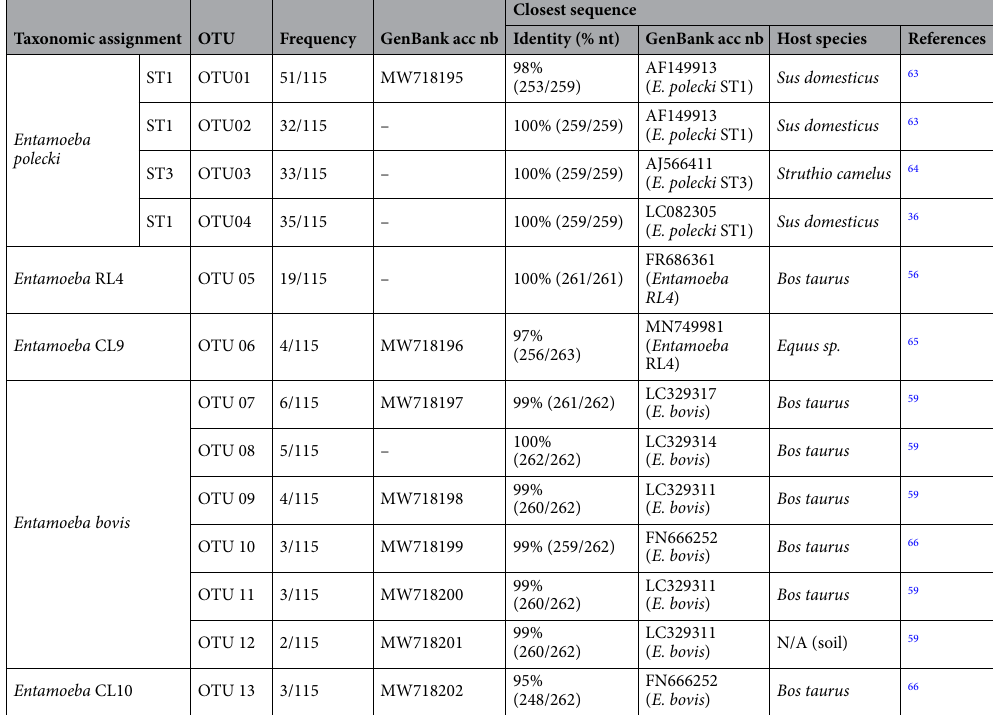
Table 2. Taxonomic assignment of OTUs (~ 260pb) detected in 65 of 115 faecal samples. Frequency of each OTU is given all hosts combined. For each OTU, information on the closest sequence (through BLASTn searches) listed in reference sequences comprise: identity of the sequence, GenBank accession number, host species from which the sequence was amplified for the first time, and bibliographic reference associated to the